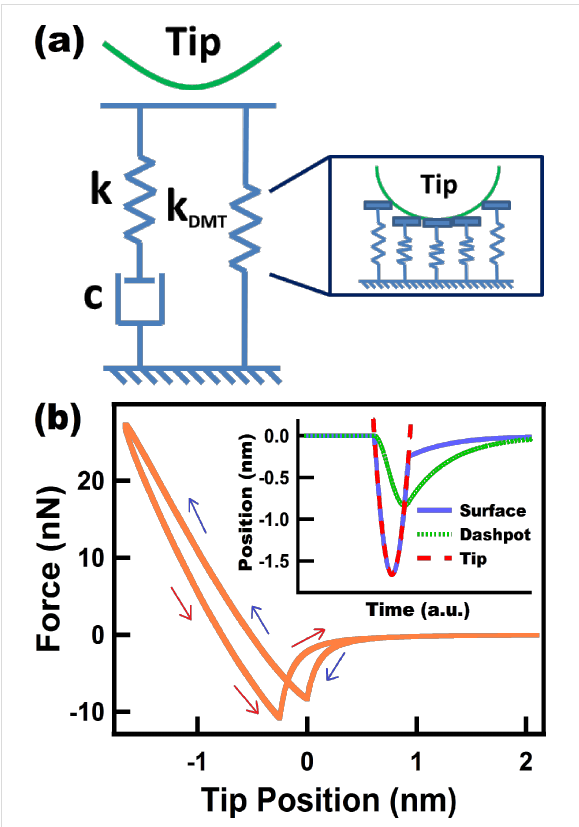
Figure 5: (a) Standard nonlinear solid (SNLS) model. (b) Tip force trajectory for a tip under a numerically simulated (not prescribed) tapping mode trajectory interacting with a SNLS sample. The inset in (b) shows the position of the surface and the dashpot over one funda- mental oscillation. The parameters for the cantilever dynamics were the same as in Figure 2b. The parameters for k DMT were the same as in Figure 4. The parameters k and c were set to 7.5 N/m and 0.5 × 10 − 5 N·s/m, respectively. The blue and red arrows in (b) corres- pond to approach and retraction of the tip,